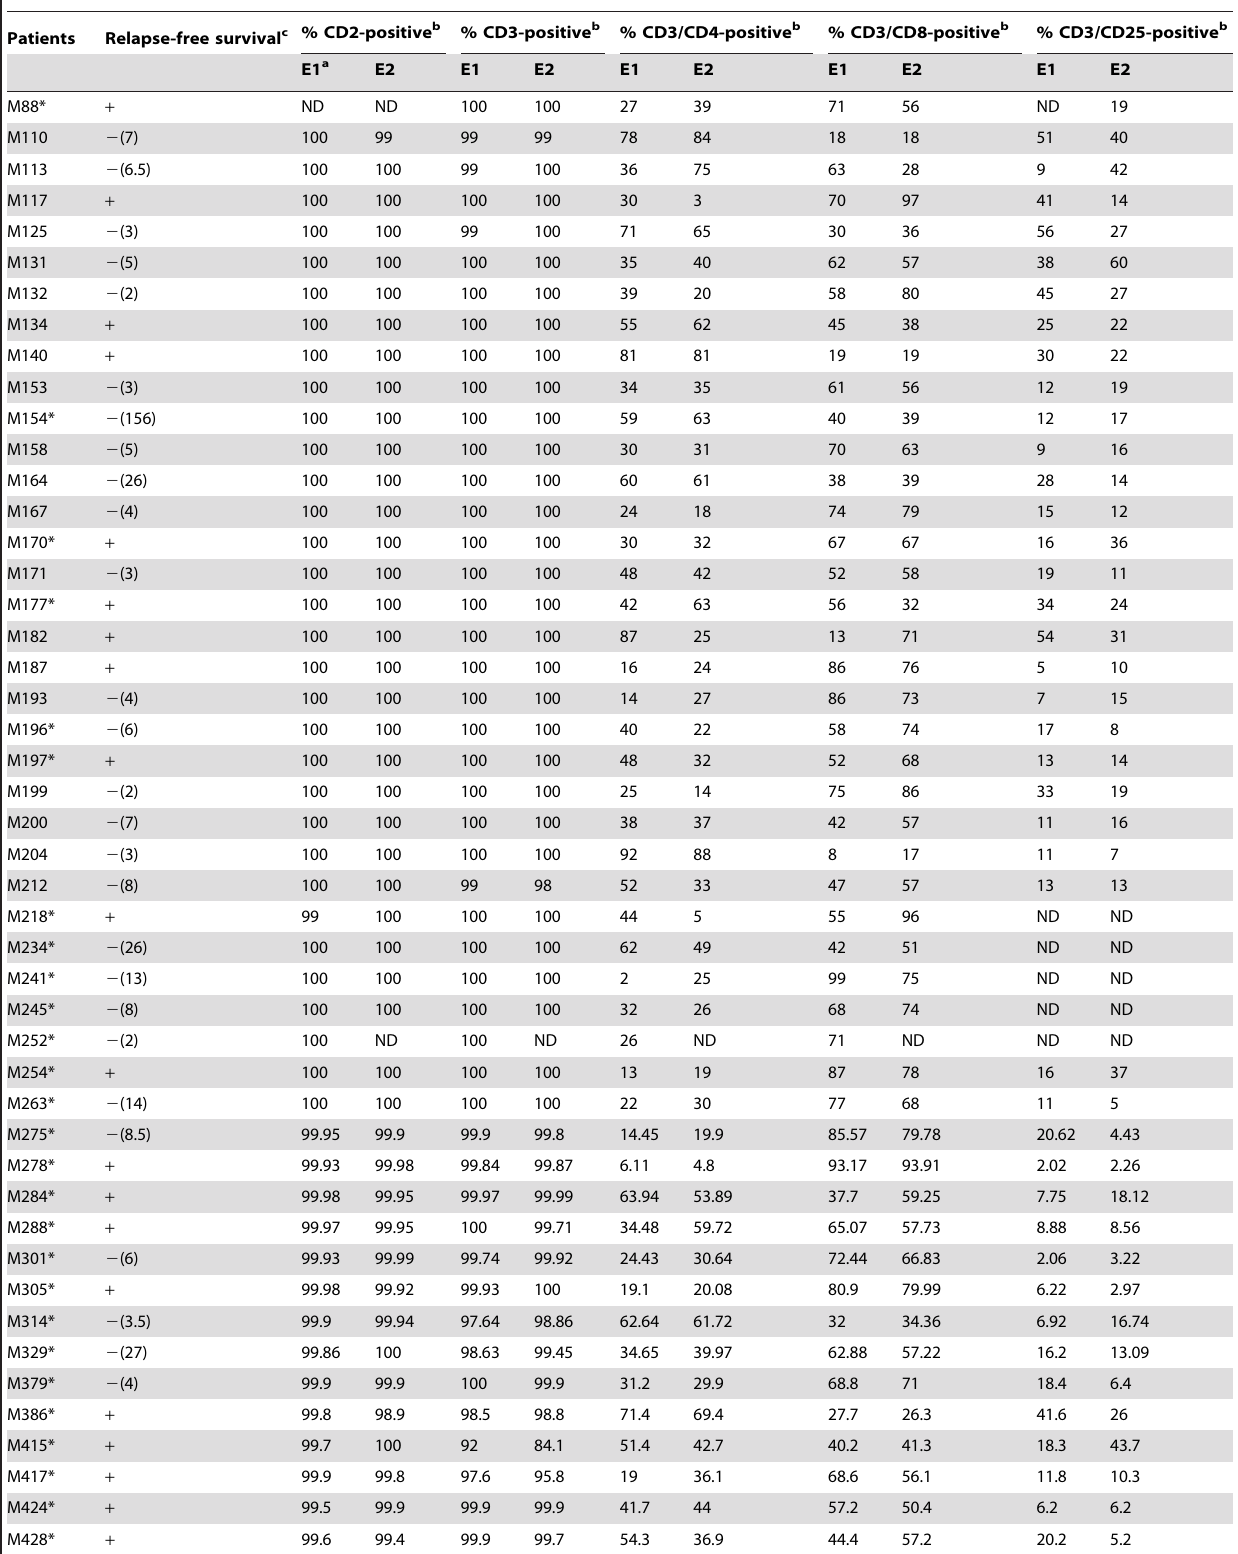
Table 1. Phenotype of large-scale expanded TIL from melanoma-invaded lymph nodes of 47 patients treated by TIL.